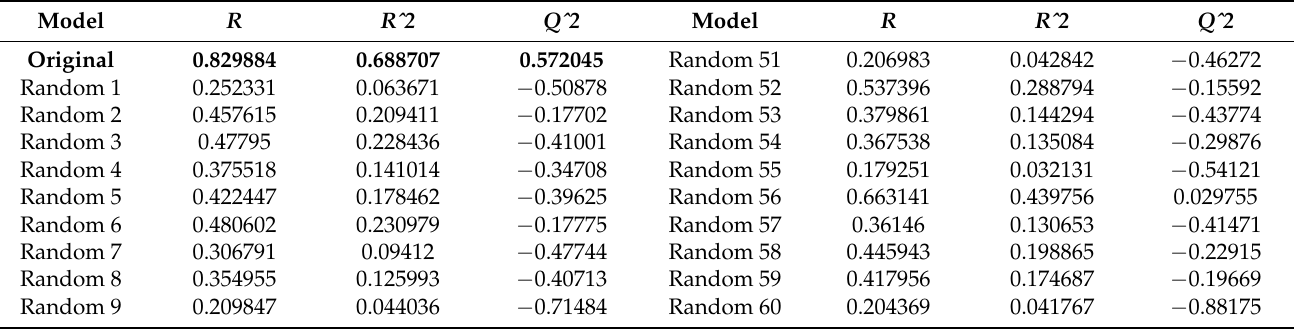
Table 6. Y-randomization test